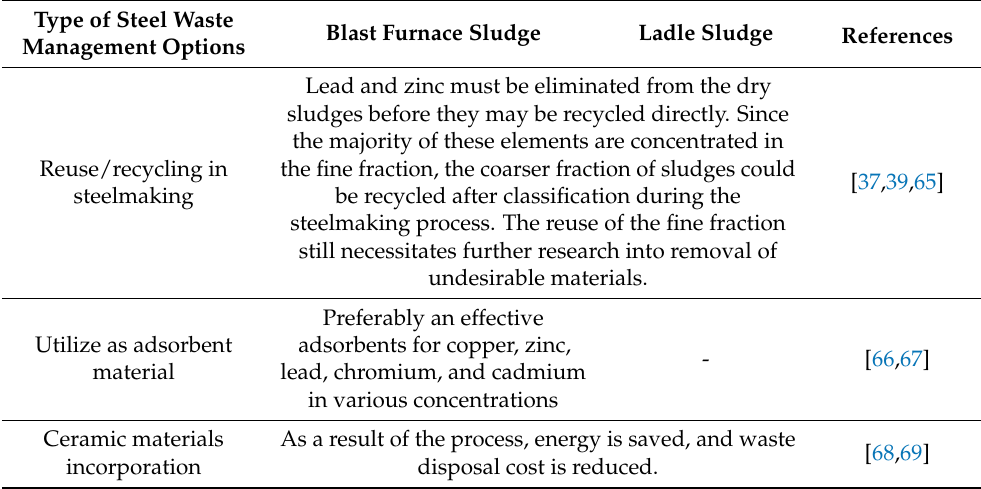
Table 5. Management options for steelmaking